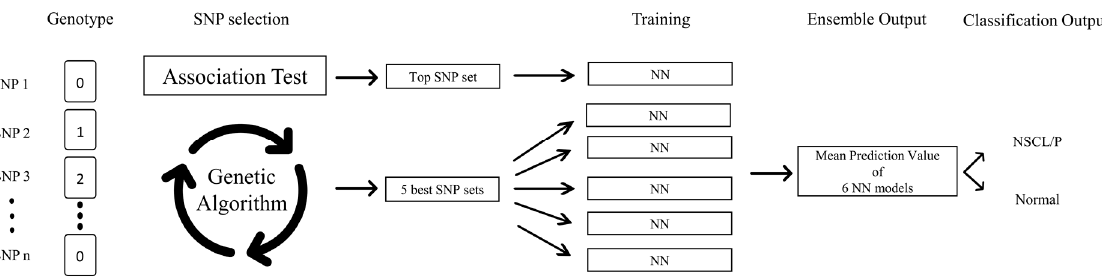
Figure 3. Overview of the GANNE pipeline for NSCL/P classification. Genotype information for each subject is encoded into a n × 1 input matrix, where n is the total number of SNPs. NN, neural network; SNP, single nucleotide polymorphism; NSCL/P, nonsyndromic cleft lip with or without cleft palate.